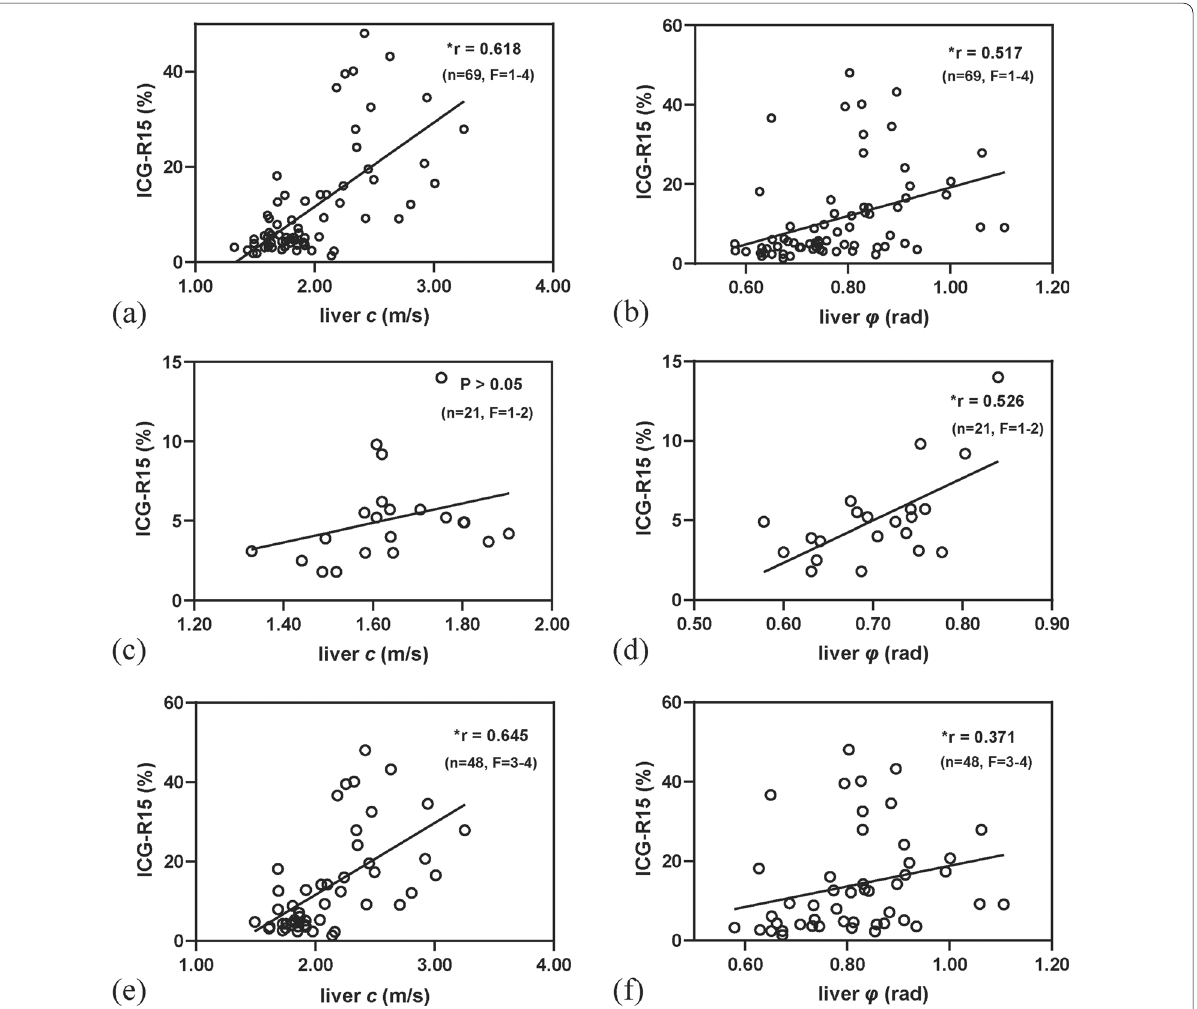
Fig. 3 Scatterplots showing that liver c ( r 0.618; p < 0.001) ( a ) and liver φ ( r 0.517; p < 0.001) ( b ) were positively correlated with the ICG-R15. In = = liver fibrosis stages F1–2, liver φ ( r 0.526; p 0.014) was positively correlated with ICG-R15 ( d ), but liver c ( p = = stages F3–4, liver c ( r 0.645; p < 0.001) ( e ) and liver φ ( r 0.371; p 0.009) ( f ) were positively correlated with the ICG-R15. * p < 0.05. ICG-R15: 15-min = = = indocyanine green retention